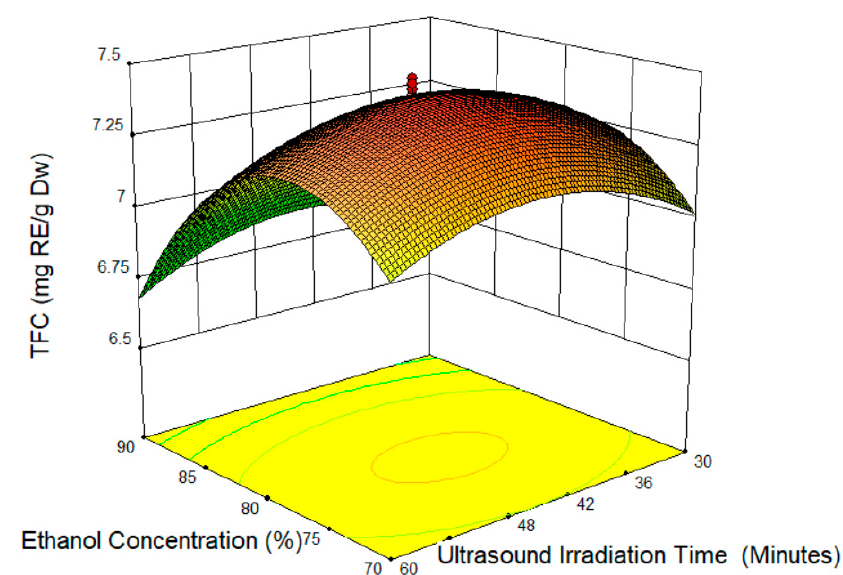
Figure 2. Response surface plot of ethanol concentration (X 1 ) and ultrasound irradiation time (X 3 ).